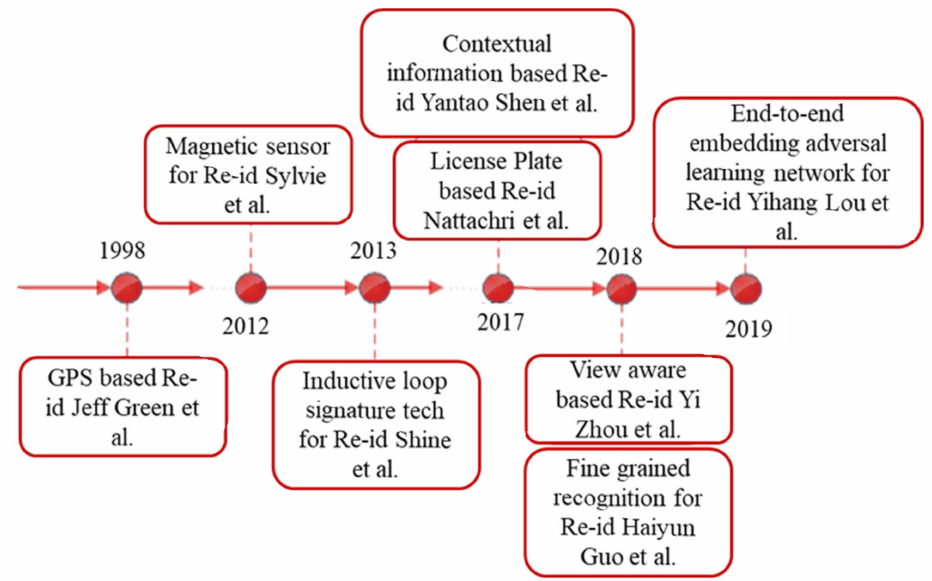
Figure 6. Milestones existing re-id approaches in the Vehicle re-id